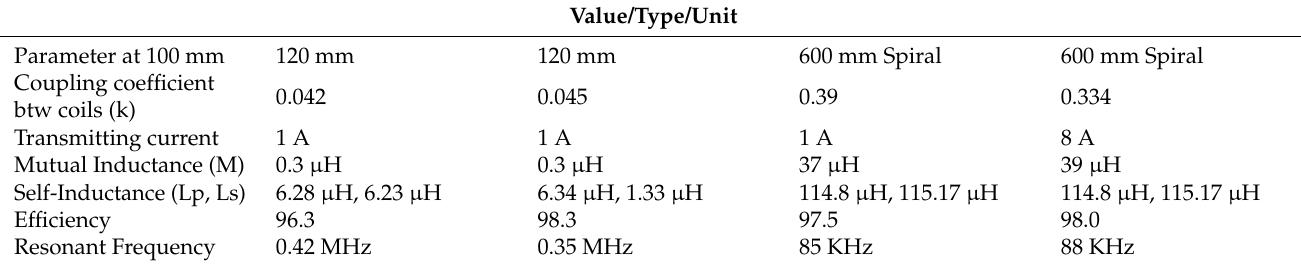
Figure 9. Results for 600 mm spiral coil: ( a ) mutual inductance vs. air gap spacing (mm), ( b ) coupling coefficient vs. air gap spacing (mm). Table 3. Results of each coil design.